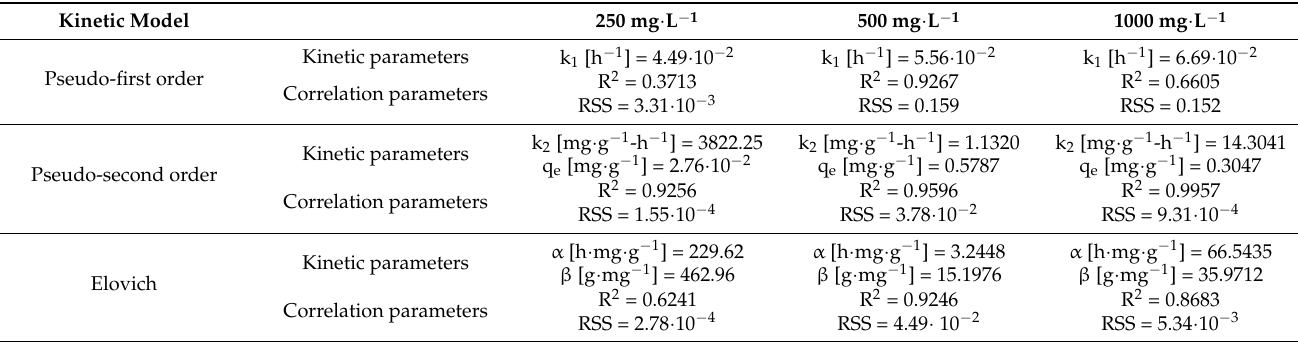
Table A3. The results of the kinetic equation adjustment to the adsorption experimental data of